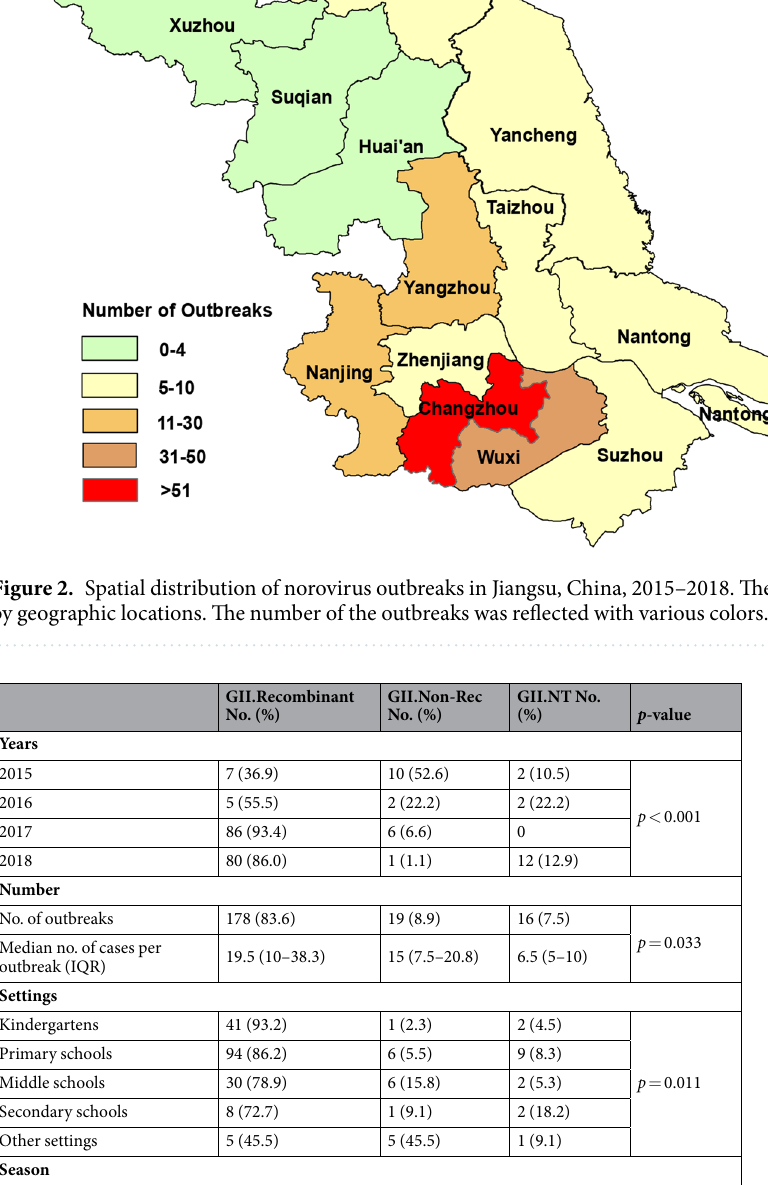
Table 1. Analysis of characteristics associated with GII.Recombinant, GII.Non-Rec and GII.NT outbreaks from 2015 to 2018 in Jiangsu, China. Categorical data are presented as frequencies with percentages; case numbers are presented as the median and interquartile range (IQR); for categorical data, differences among groups were examined using the chi-square test or Fisher’s exact probability test. For continuous data, Kruskal-Wallis Test was used to determine differences among